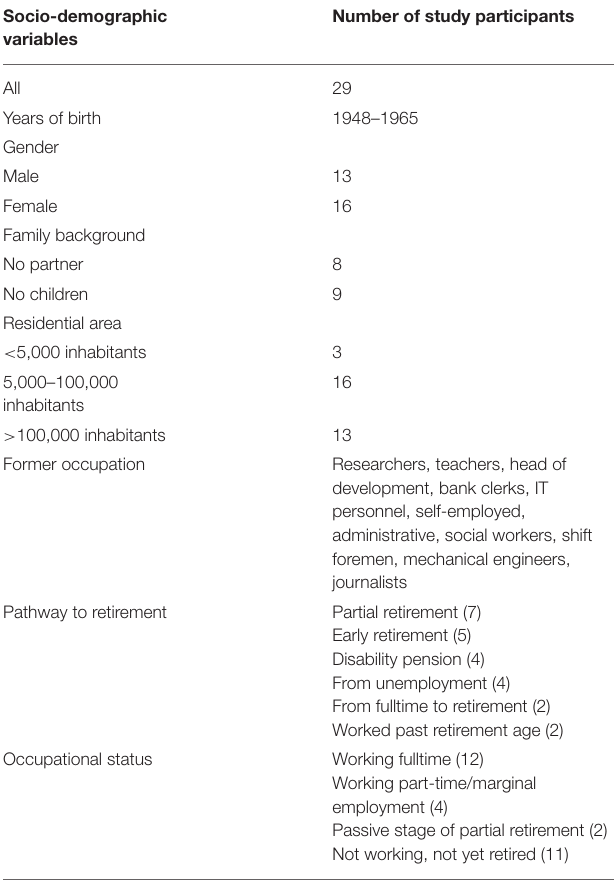
TABLE 2 | Sample description by socio-demographic